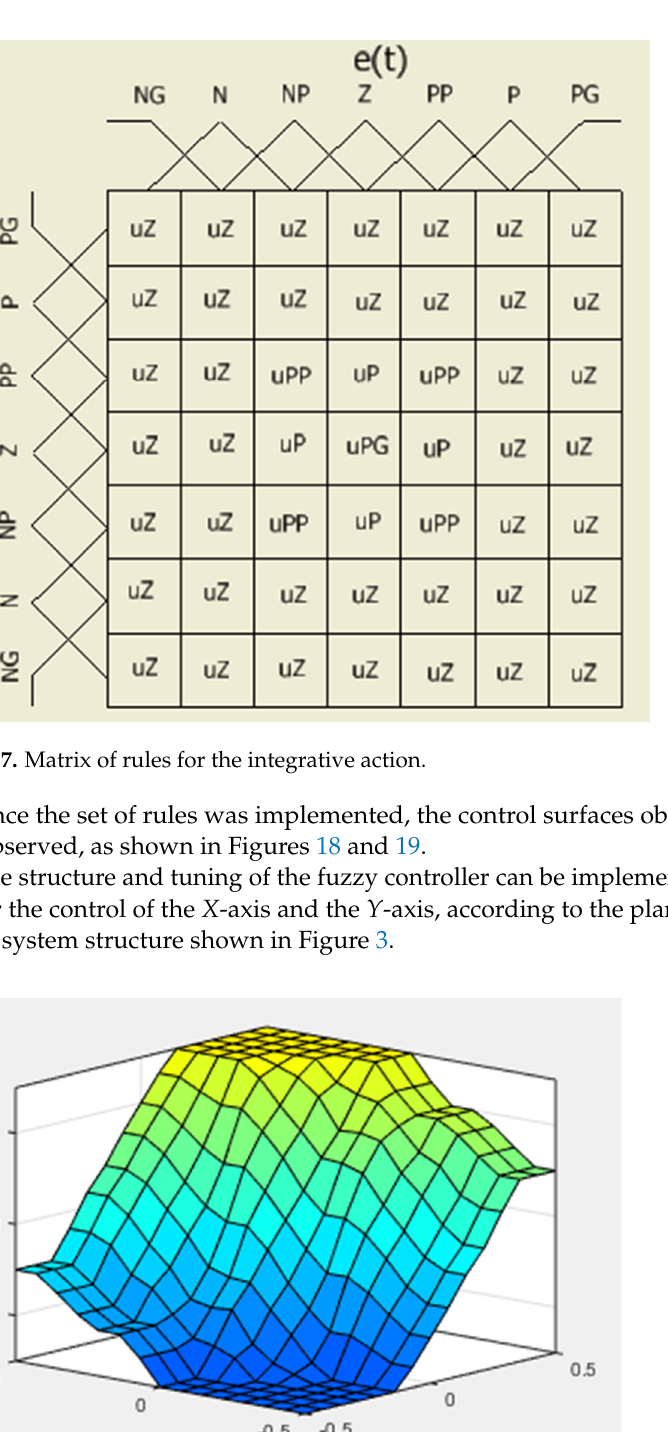
Figure 16. Matrix of rules for the proportional – derivative action.